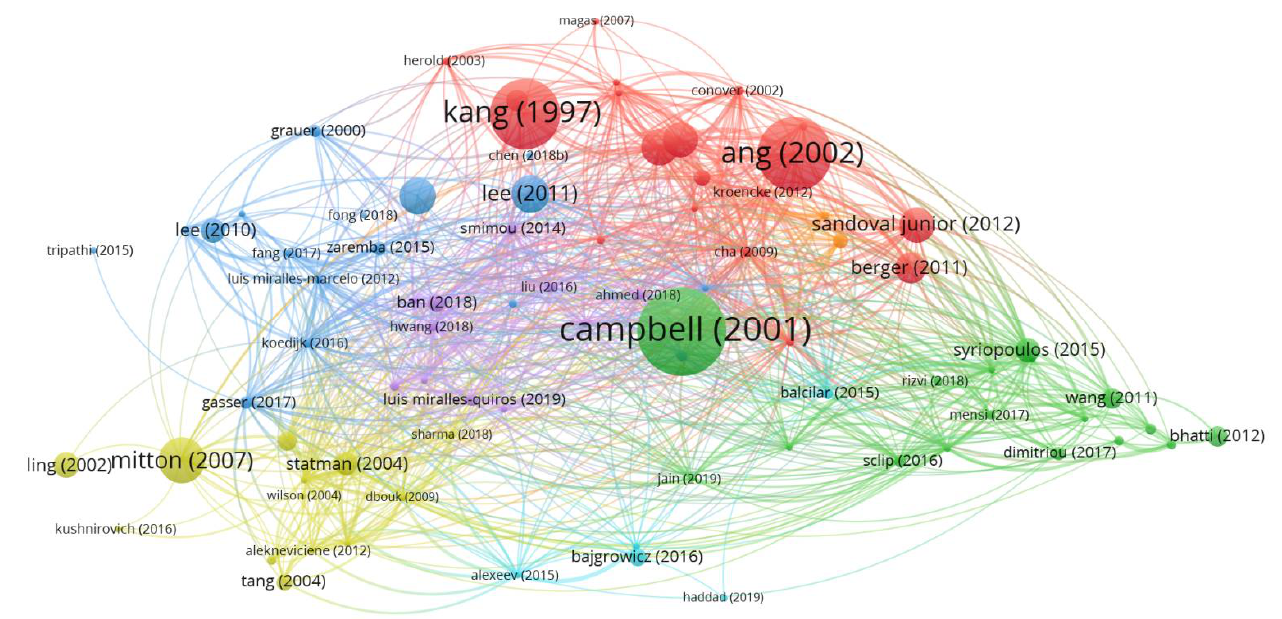
Figure 3. Most influential authors organized in clusters.